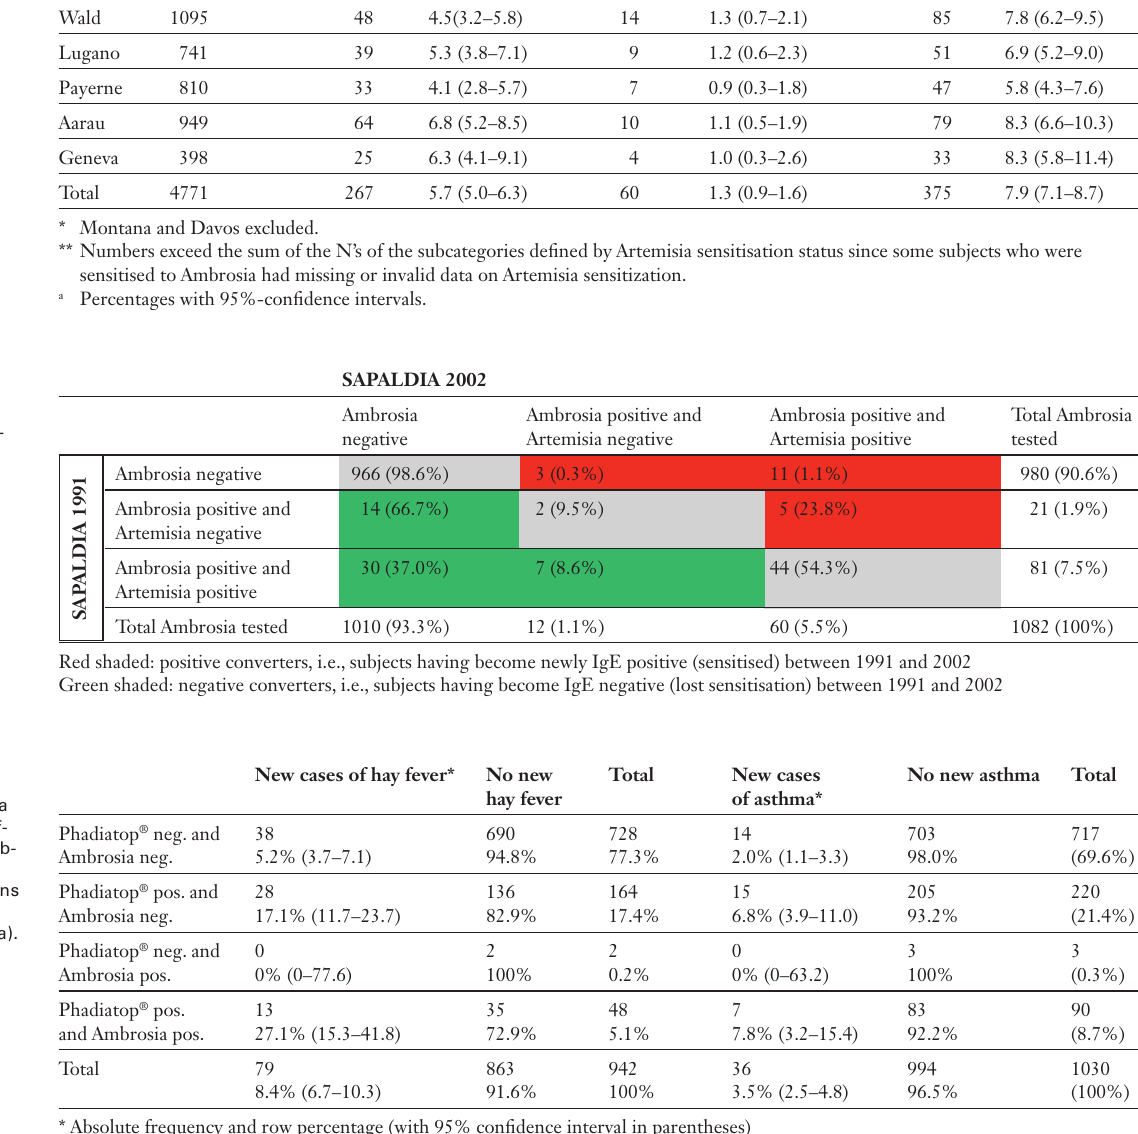
Ambrosia and Artemisia sensitisa- tion in the SAPALDIA areas* in 2002.